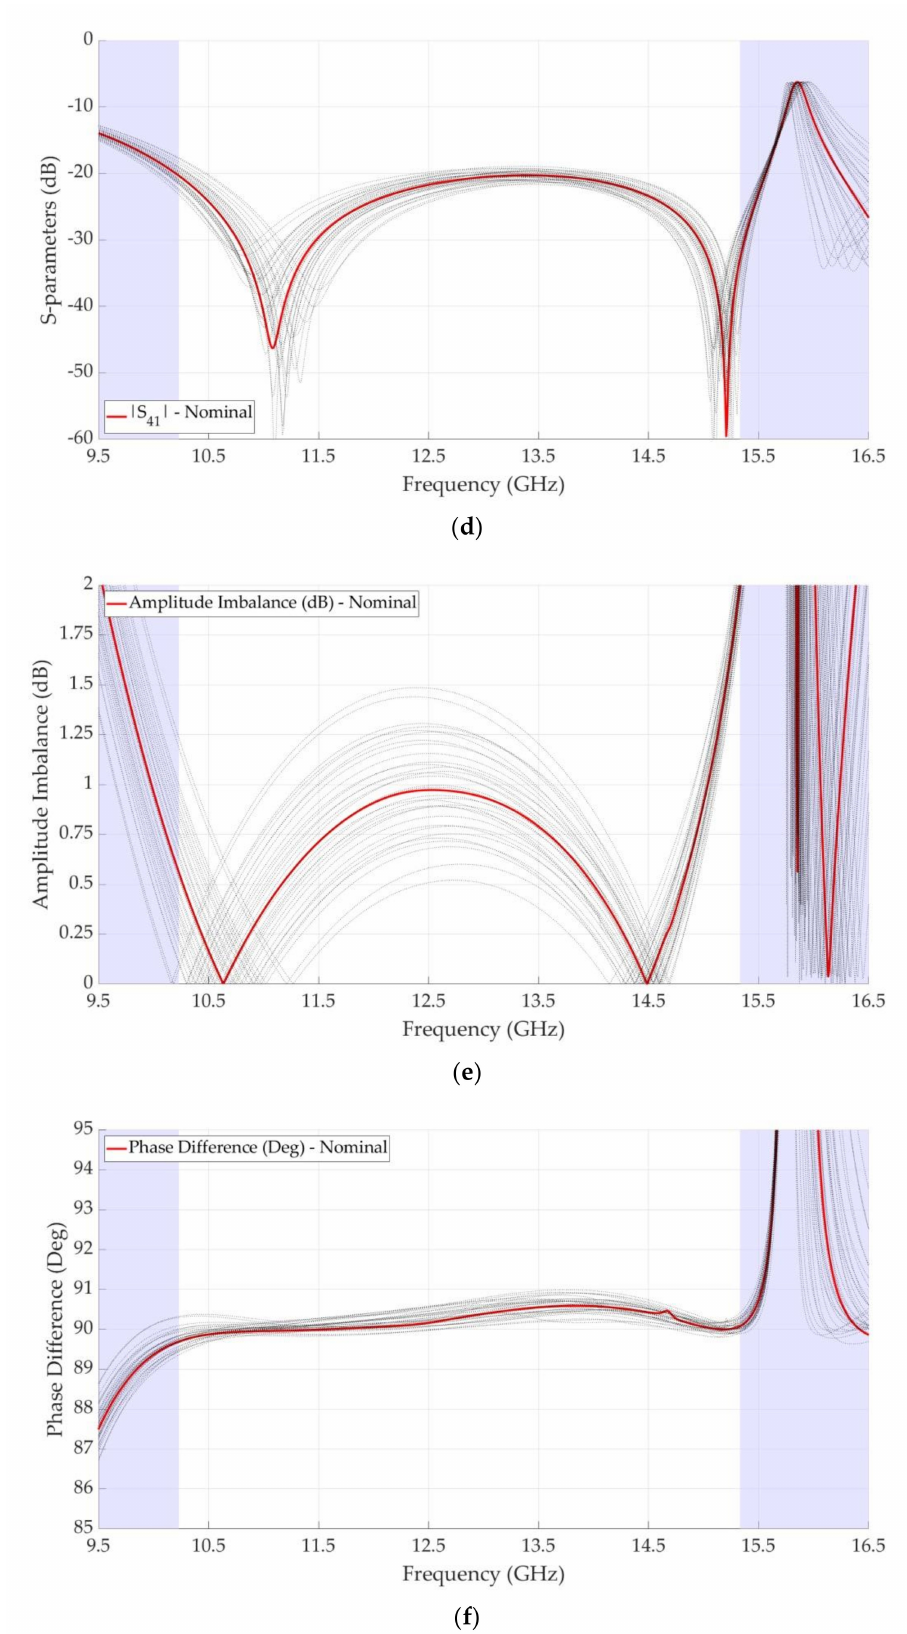
Figure 5. Hybrid coupler 1 (HC1) tolerance analysis simulations. ( a ) | S 11 |. ( b ) | S 21 |. ( c ) | S 31 |. ( d ) | S 41 |. ( e ) Amplitude imbalance. ( f ) Phase